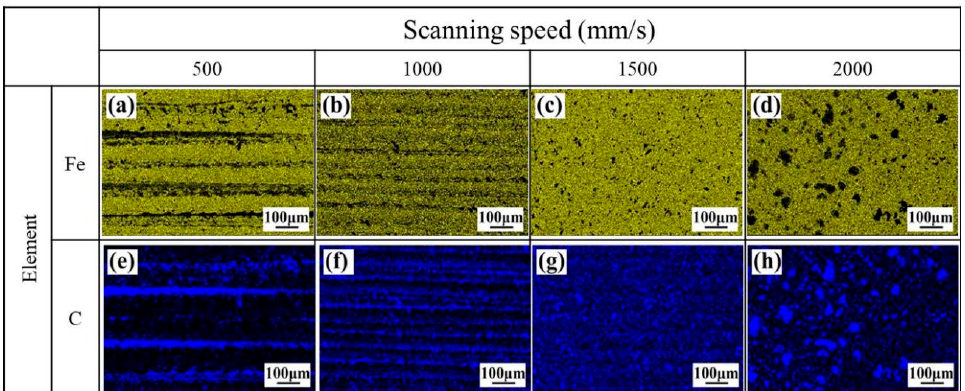
Figure 7. The effect of laser X-scanning speed on the distribution of the elements of the cleaned surface. ( a ) Fe, at 500 mm/s; ( b ) Fe, at 1000 mm/s; ( c ) Fe, at 1500 mm/s; ( d ) Fe, at 2000 mm/s; ( e ) C, at 500 mm/s; ( f ) C, at 500 mm/s; ( g ) C, at 500 mm/s; ( h ) C, at 500 mm/s.